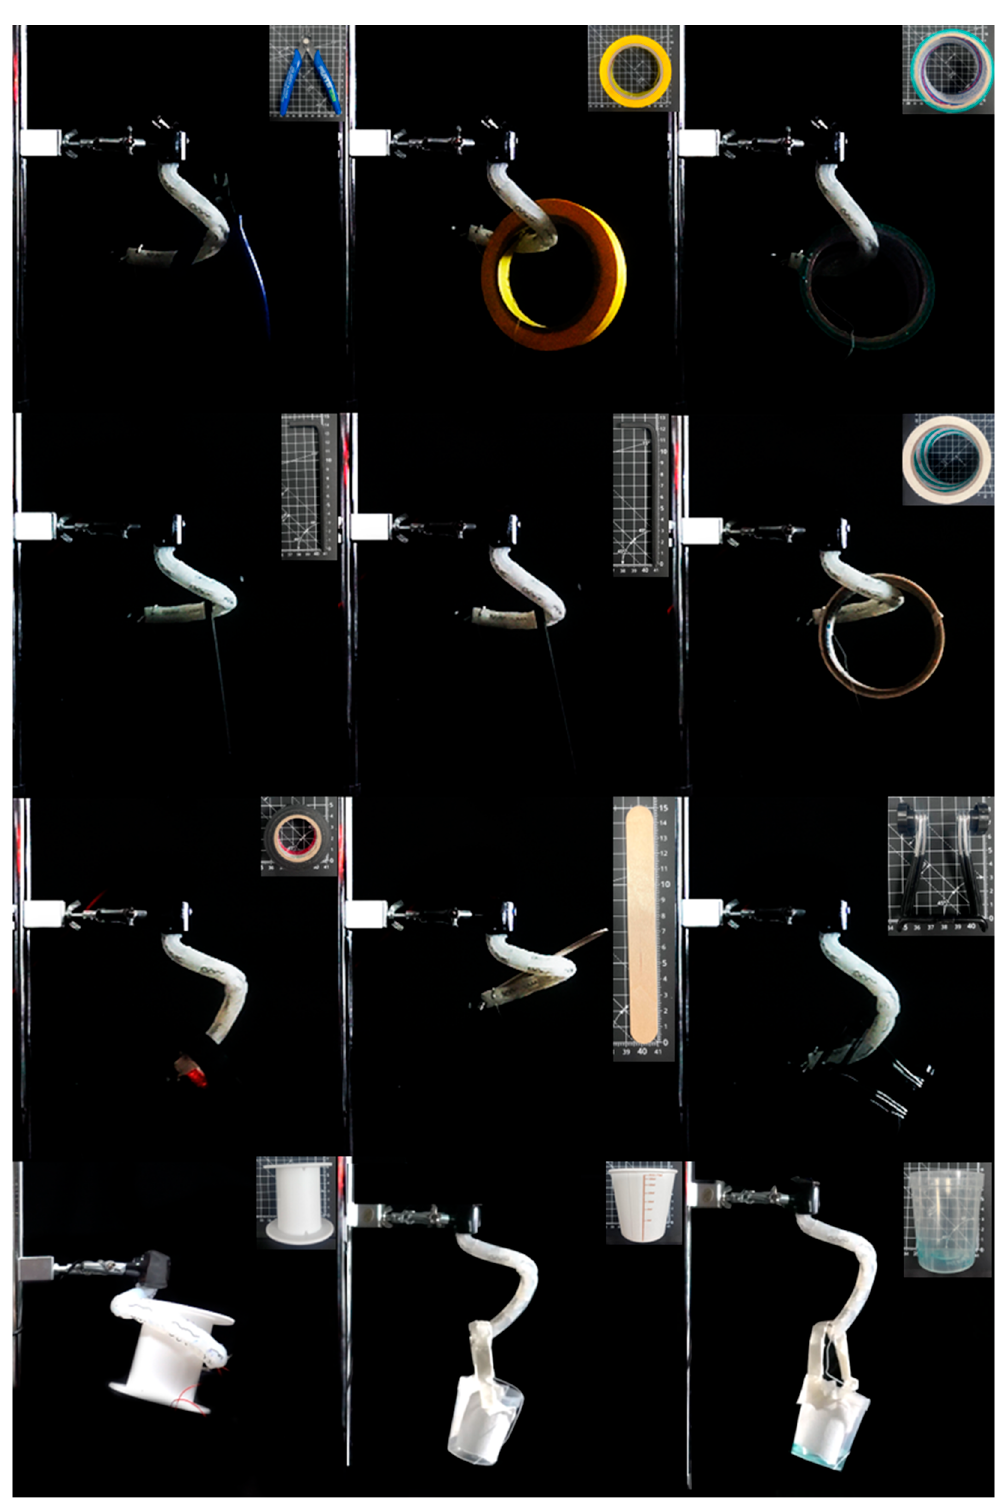
Figure 8. Evaluations of grasping performance: the elephant trunk actuator can grip various objects including yellow paper tape, duct tape, white paper tape, friction tape, a wooden stick, a big hexagonal wrench, a small hexagonal wrench, a phone holder, a nipper, wire container, a paper cup, and a beaker. The target objects were arranged from left to right and from top to bottom.